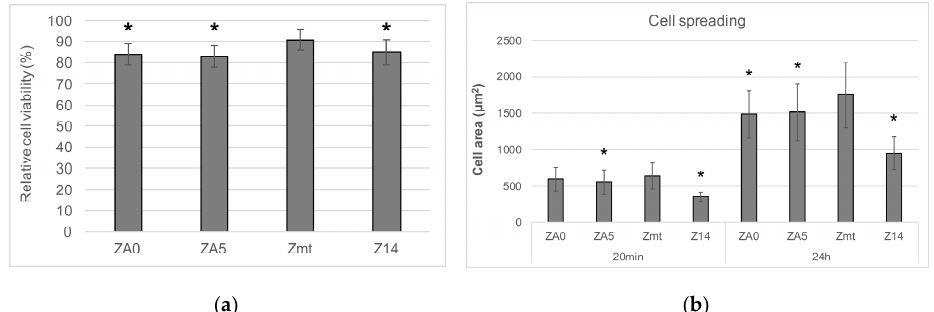
Figure 3. ( a ) Mean relative cell viability and standard deviation after 24 h in% normalized to the control cells grown on well bottoms. Statistically significant differences in specimens compared to uncoated zirconia specimens (Zmt), determined with a post-hoc Fisher LSD test, are indicated with * ( p < 0.001). ( b ) Human osteoblastic cell (MG-63) area after 20 min and 24 h on differently treated zirconia specimens. Statistically significant di ff erences in specimens compared to the control Zmt of the respective group of either 20 min or 24 h, determined with a post-hoc Fisher LSD test, are indicated with * ( p < 0.001), n = 40 cells per group × 3 independent experiments, mean ± standard deviations.